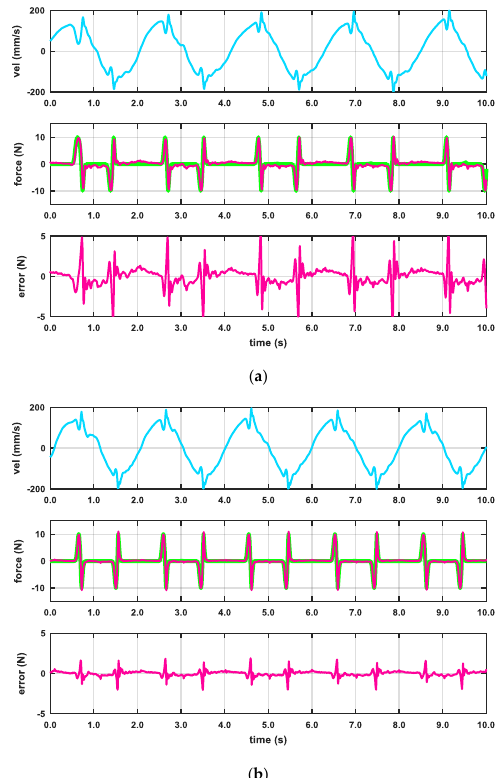
Figure 14. The control response at the bump ( D = 1000 rad/s): ( a ) m d